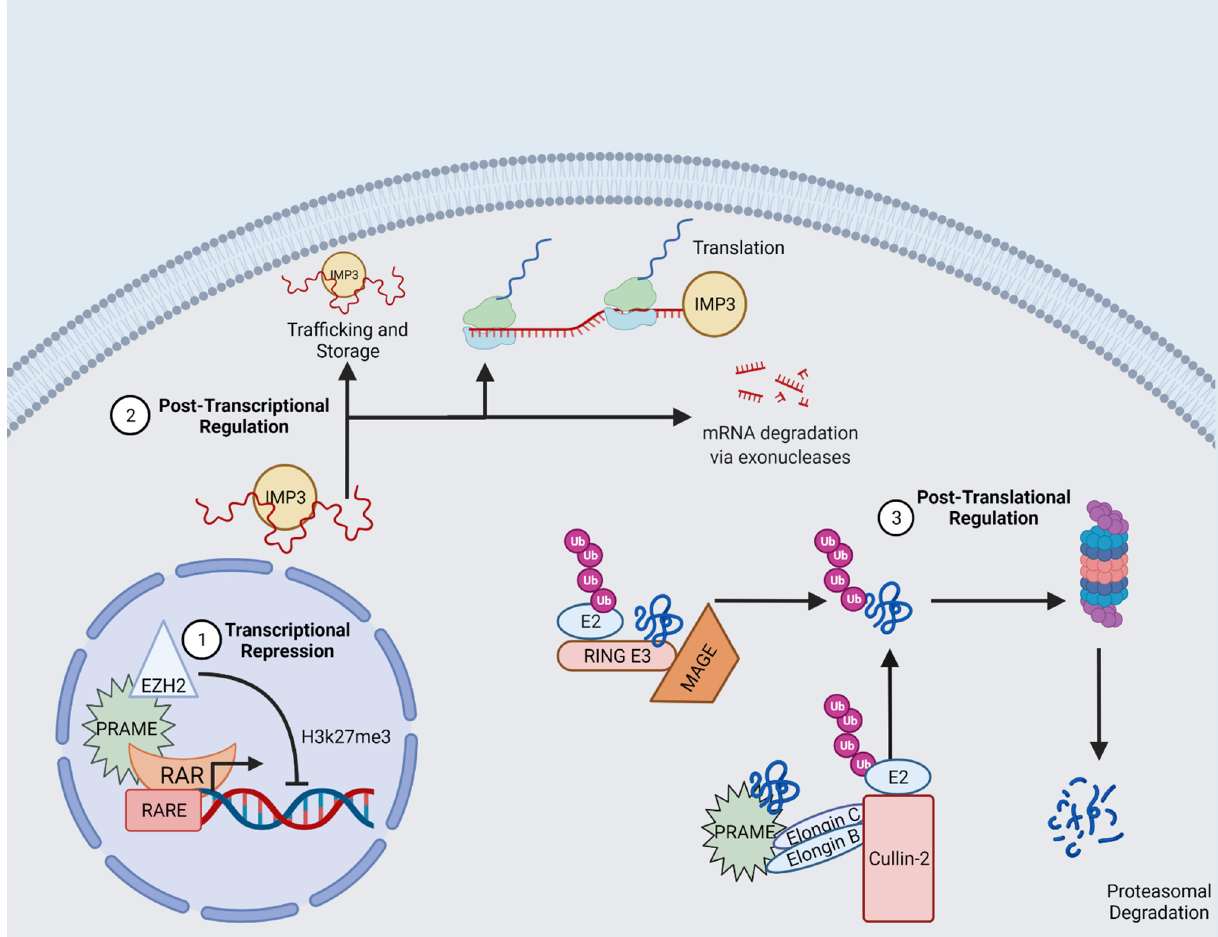
Figure 1. Ectopic CTA gene expression regulation at the transcriptional, post-transcriptional and post-translational levels. PRAME mediates transcriptional repression of retinoid signaling. IMP3 can regulate post-transcriptional regulation of gene expression, controlling mRNA trafficking and storage, translation and degradation. Both PRAME and MAGE regulate proteasomal degradation of certain substrates. Figure created using BioRender.com.